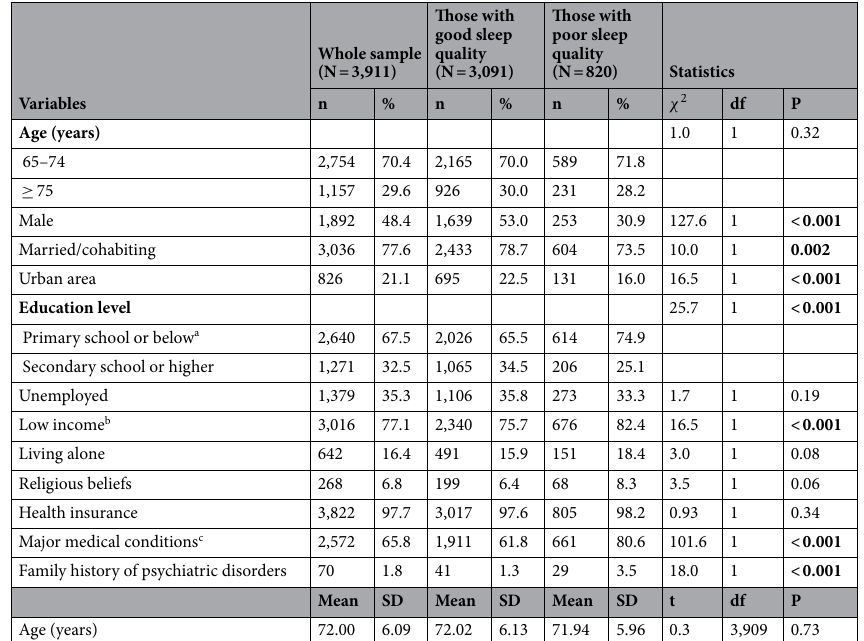
Table 1. Socio-demographic characteristics of the study population (N = 3,911) by sleep quality. Bolded values: < 0.05; M mean, PSQI Pittsburgh Sleep Quality Index, SD standard deviation. Good sleep quality was defined as Pittsburgh Sleep Quality Index (PSQI) < 7. a Primary school or below = less than 7 years of education. b Low income: annual household income < RMB30,000 (approximately USD4,242). c Major medical conditions included hypertension, diabetes, cerebrovascular disease, cancer, and gastrointestinal